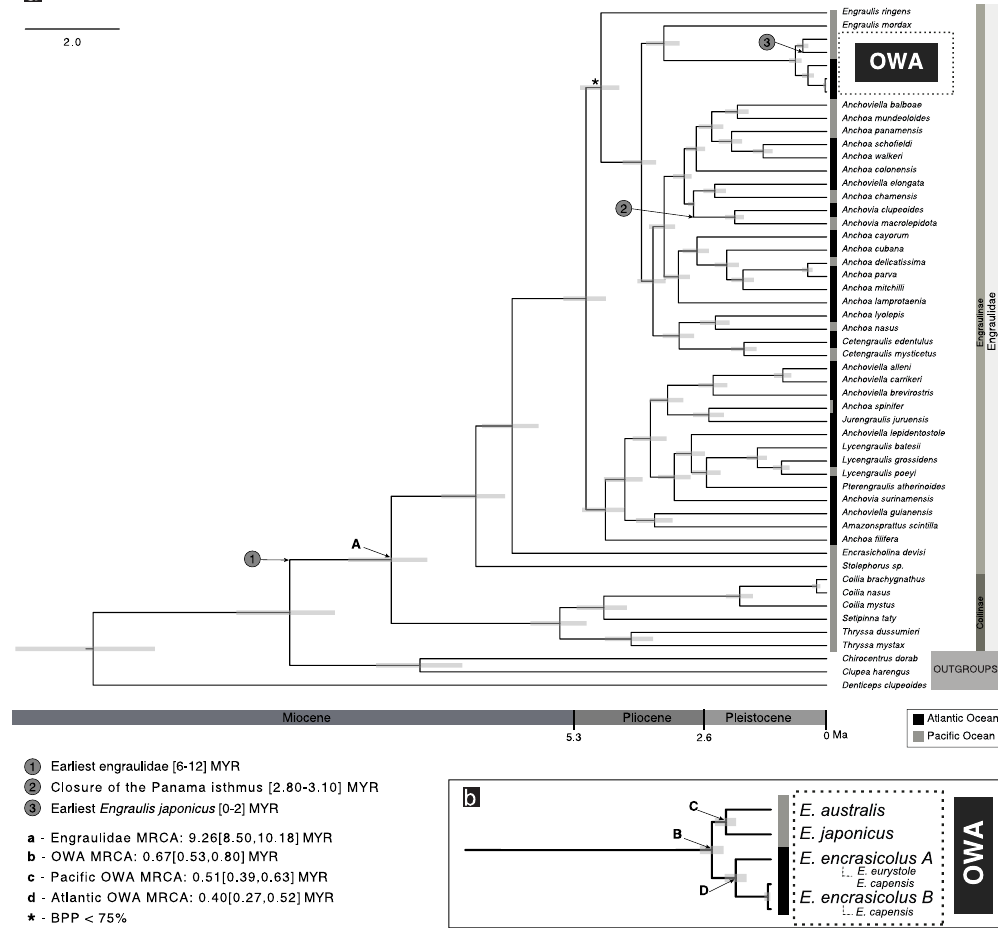
Figure 5. ( a ) Bayesian dating analysis of the Engraulidae family based on the concatenation of mitochondrial (cytochrome b : 1131 bp and 16S rRNA: 800 bp) and nuclear (RAG1: 1480 bp and RAG2: 1221 bp) gene fragments; ( b ) inset of the Old World Anchovies (OWA); numbers (1) and (3) are fossil calibrations, while number (2) represents a geologic event calibration; (A) (B) (C) (D) are relevant nodes ages; all branches show BPP > 75% except the node signed with *